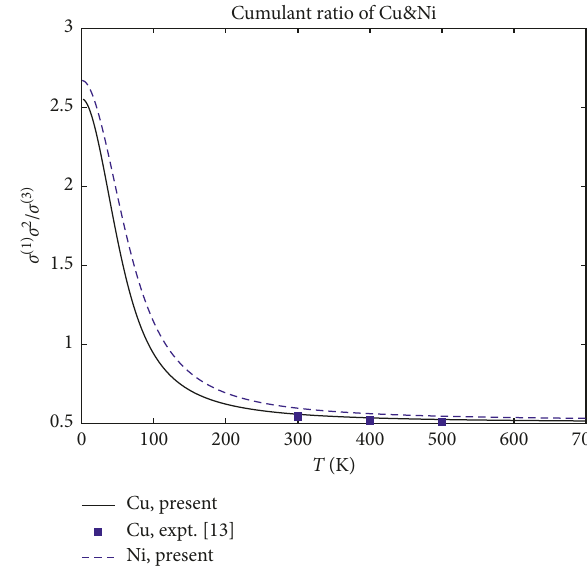
Figure 4: Temperature dependence of second cumulant σ 2 Cu and Ni calculated using the present theory compared to the experimental values (Expt.) [13, 22, 23, 25] for Cu and [23] for Ni, as well as to those calculated using the ACEM [9], SMM [16], FCM [20], and LDA [21] for Cu and PIEP [18] for Ni.